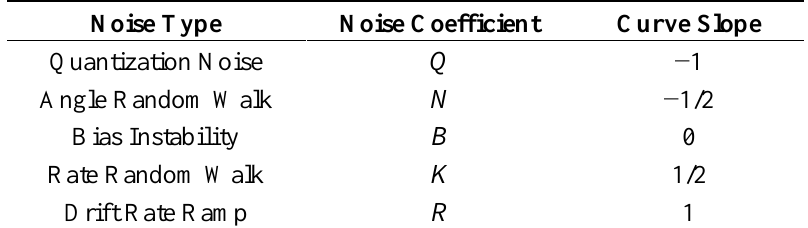
Table 1. Summary of characteristic noise coefficients and curve